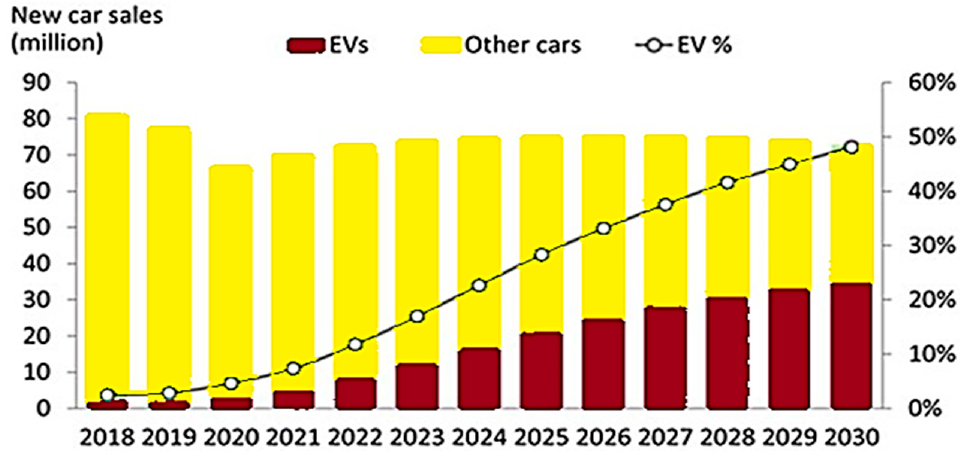
Figure 2. Expected car sales [13].